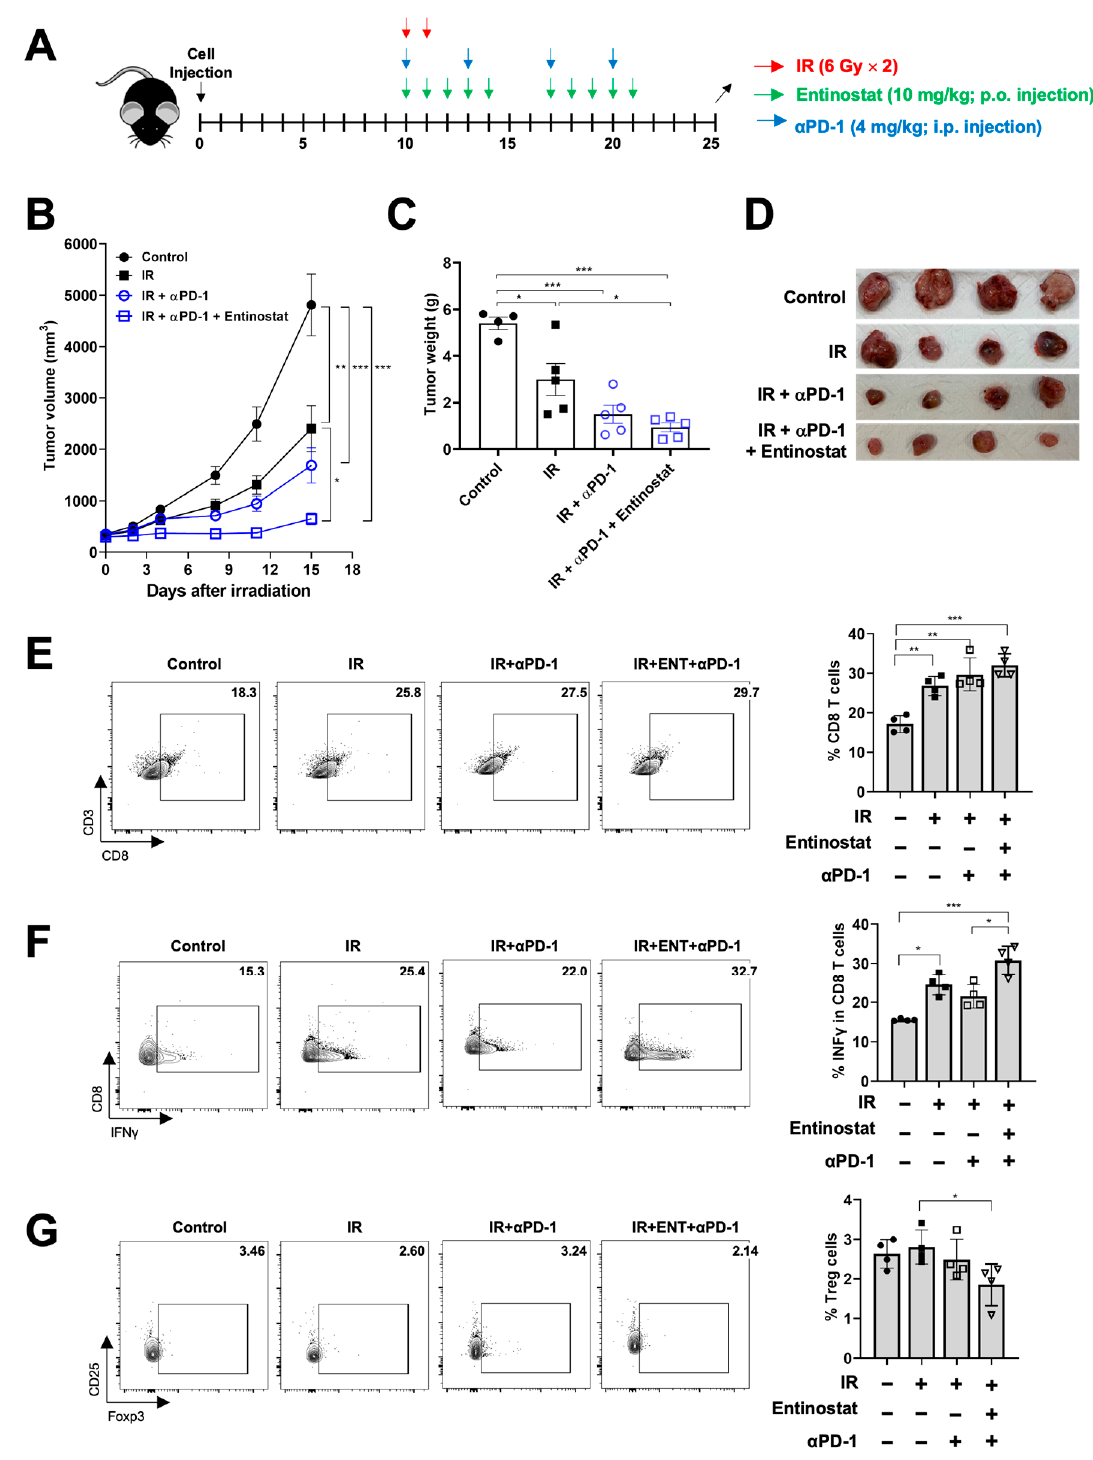
Figure 5. Entinostat sensitizes LL/2 tumors to IR plus anti-PD-1 treatment. ( A ) Scheme for radiation, entinostat, and anti-PD-1 treatments. ( B ) Tumor growth curves showing delayed growth of LL/2 tumors in mice treated with triple combinations. ( C ) Comparison of tumor weight at day 15 after irradiation. ( D ) Photographs of tumors harvested from the mice at day 15 after irradiation. ( E – G ) Flow cytometric analysis of CD8 + T ( E ), IFN- γ -producing CD8 + ( F ), and Treg ( G ) cells infiltrated in tumors. Representative density plots are shown. Data are mean ± S.D. ( n ≥ 4). * p < 0.05; ** p < 0.01; *** p < 0.001.